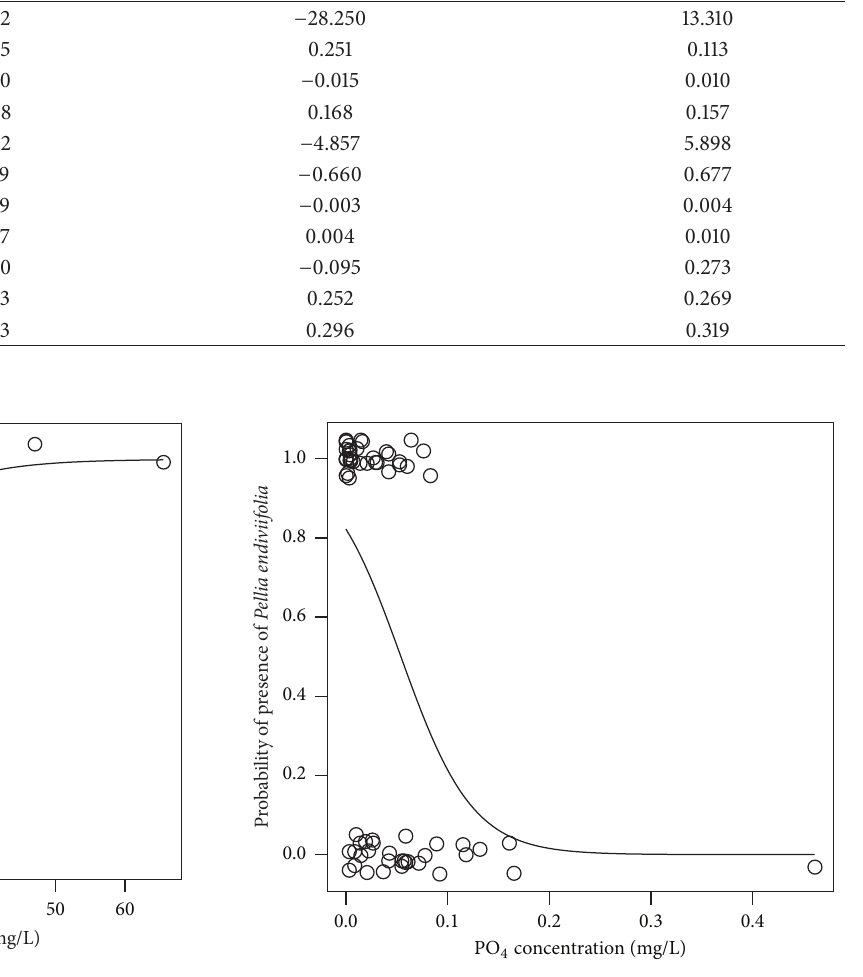
Figure7:Predictionofpresenceof Cratoneuronfilicinum inrelation to Mg concentration based on the coefficients of the best models selected by AIC stepwise selection.